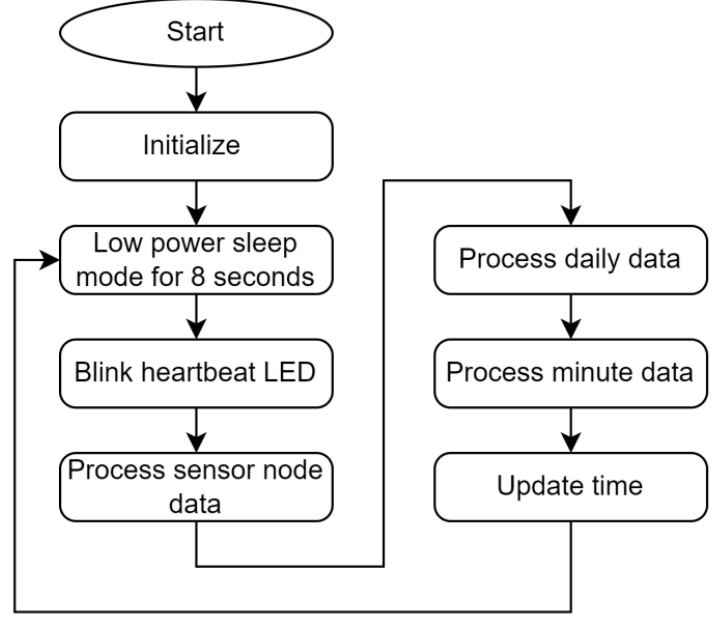
Figure 9. Flowchart of the hub node firmware.